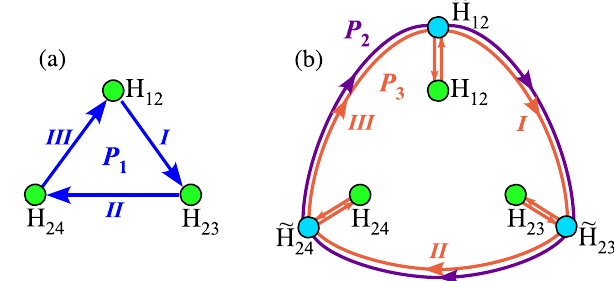
, for 1 (blue), whose Hamiltonians 2 . P (red) is a path equivalent to P , in 1 3 2 evolves to the 2 and then 1